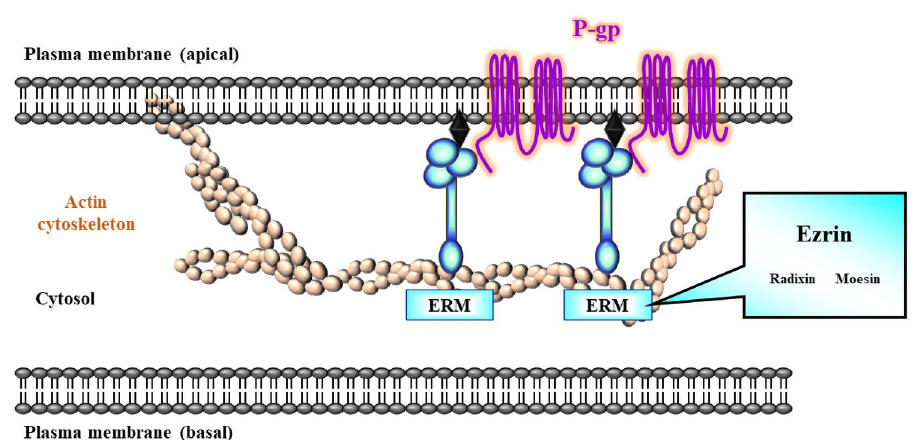
Fig 8. Schematic diagram of the proposed mechanism by which ezrin contributes to the cell surface localization and functionality of P-gp in LS180 cells. Among the ERM proteins, ezrin plays a key role as an anchor protein to stabilize P-gp on the surface of the plasma membrane, which in turn regulates the transport function of P-gp in LS180